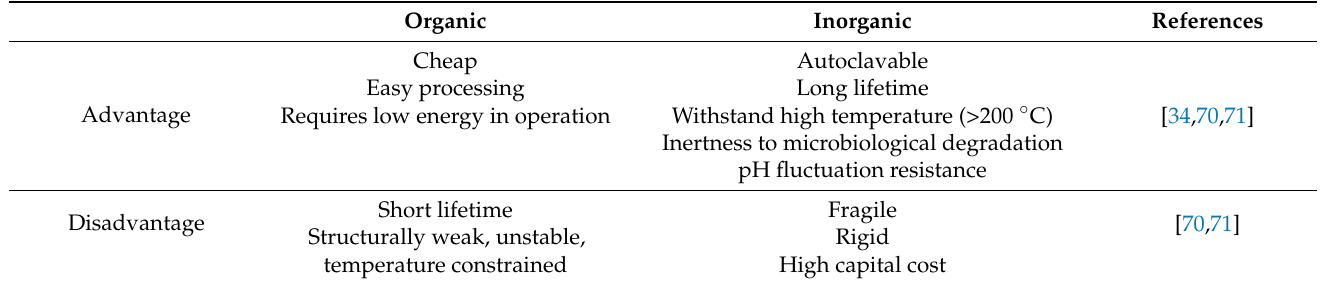
Table 4. Comparison between organic and inorganic membranes.